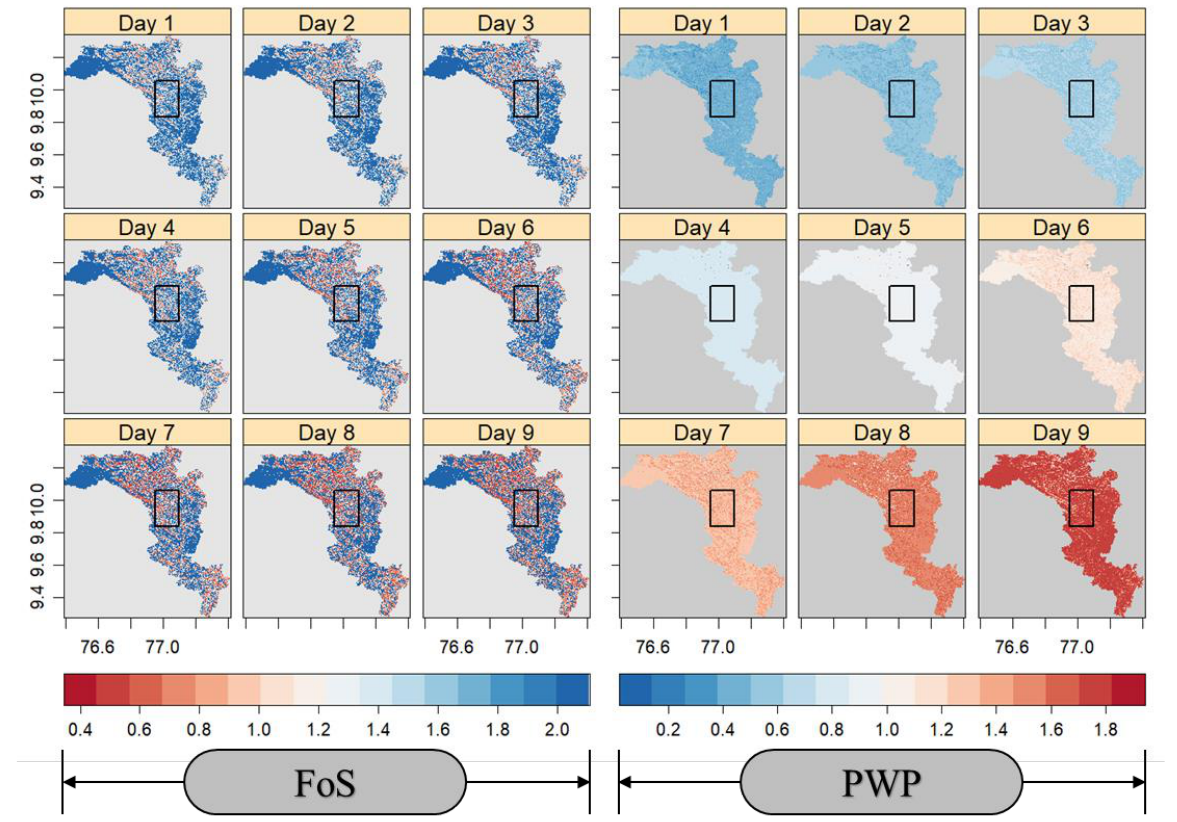
Figure 11. ( Left ) Decrease in factor of safety (FoS) in the catchment region for the 9-day rainfall period. Day 1 ( top left ) is the plot of FoS at each pixel at the end of a 24 h rainfall period, and day 9 is the FoS at each pixel at the end of a 9-day rainfall period. Red region indicates lower-FoS and unstable areas, and blue region indicates higher-FoS and stable area. ( Right ): Rise in pore water pressure (PWP) in the catchment region for the 9-day rainfall period. Day 1 ( top left ) is the plot of PWP at each pixel at the end of a 24 h rainfall period, and day 9 is the PWP at each pixel at the end of a 9-day rainfall period. Red region indicates higher PWP (relatively unstable), and blue region indicates lower PWP (relatively stable). The nine selected landslides are located in the black rectangle (not shown in this plot). Note that the color keys are reversed for easy demarcation of relatively unstable (i.e., red) areas.